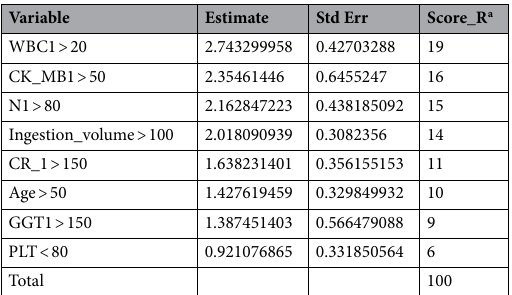
Table 2. Final risk prediction model for in-hospital death based on training sample. a Risk scores were calculated by dividing a risk factor’s coefficient by the sum of all coefficients, multiplying by 100, and rounding to the nearest integer.